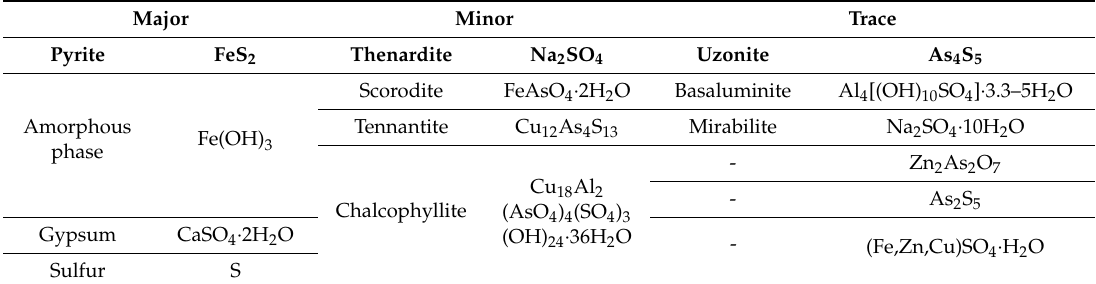
Table 5. Mineral composition of the precipitates after the experiment with Na 2 S (XRD